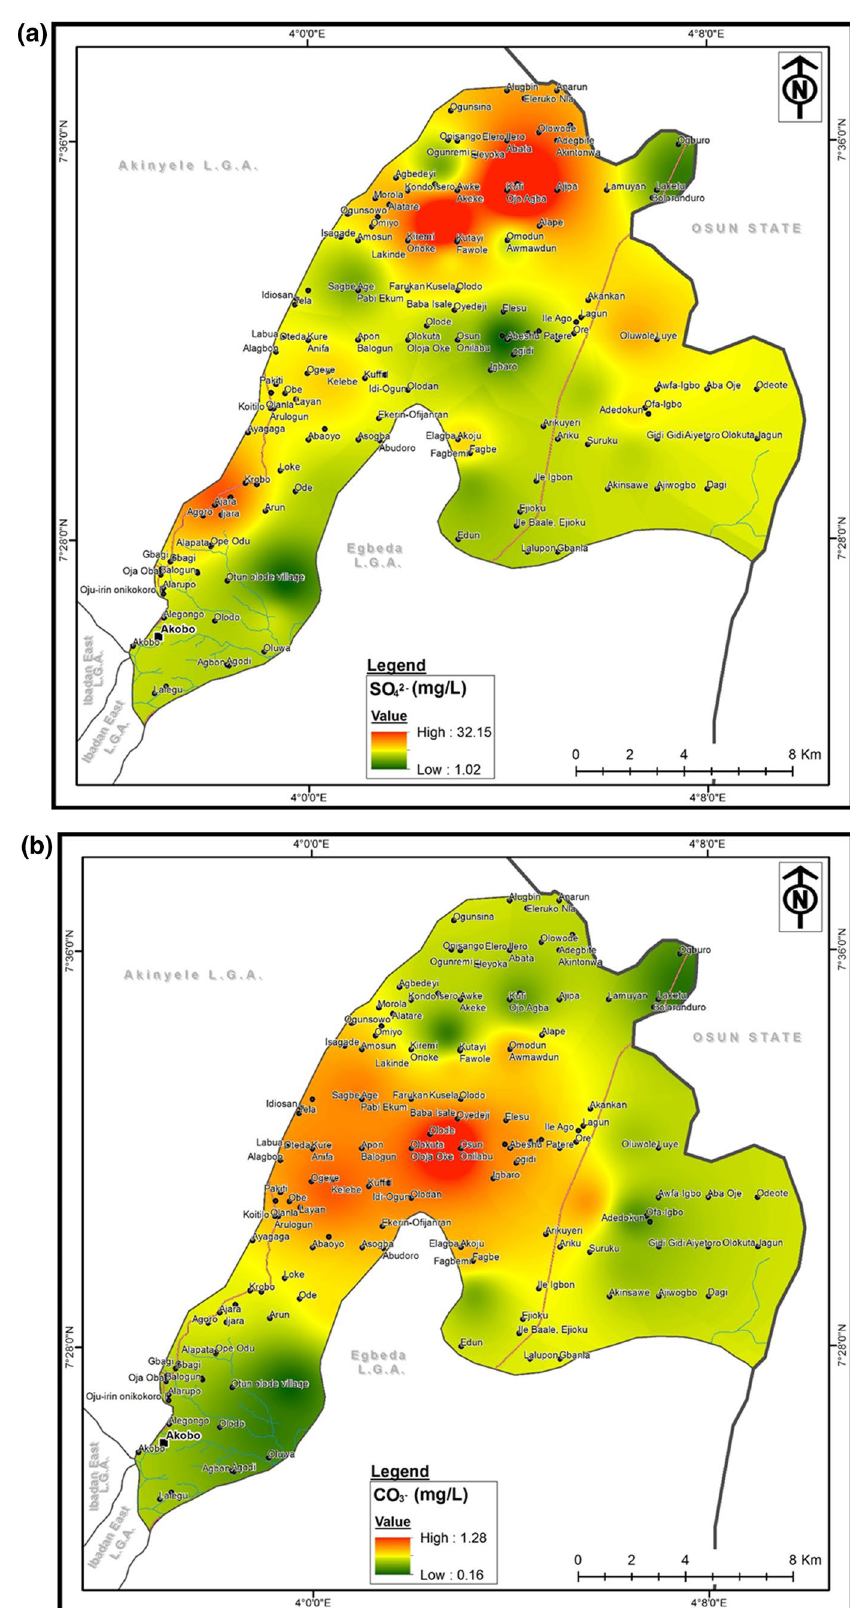
Fig. 4 Spatial disparity maps of a SO 42− b CO 3− , c Cl − , and d HCO